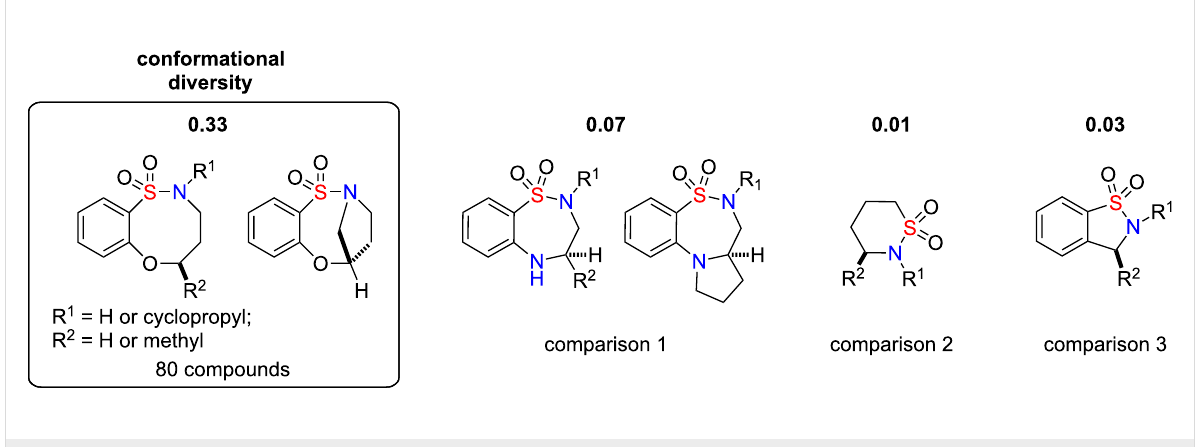
Figure 5: Comparison of a small set of our representative compounds versus two sultams synthesized by our group as well as a biological active compound [11].